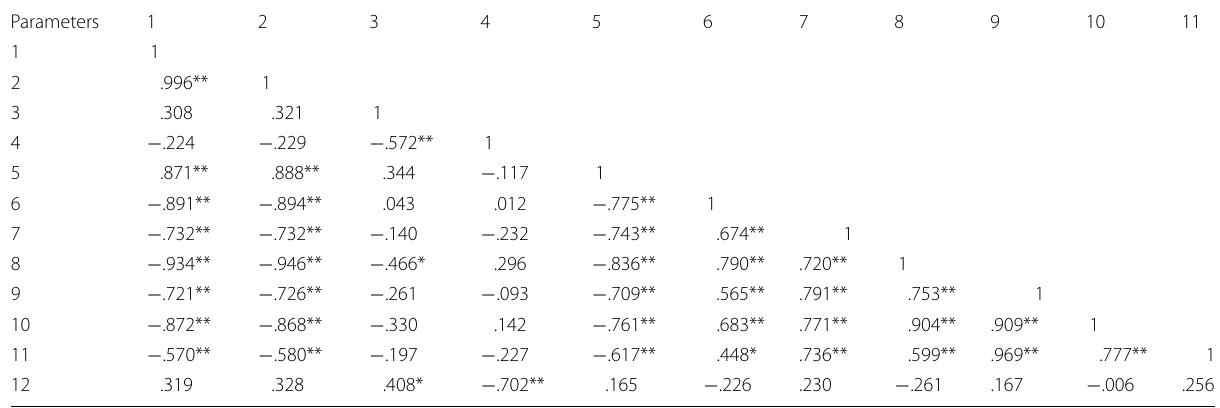
*Correlation is significant at the 0.05 level (2-tailed) **Correlation is significant at the 0.01 level